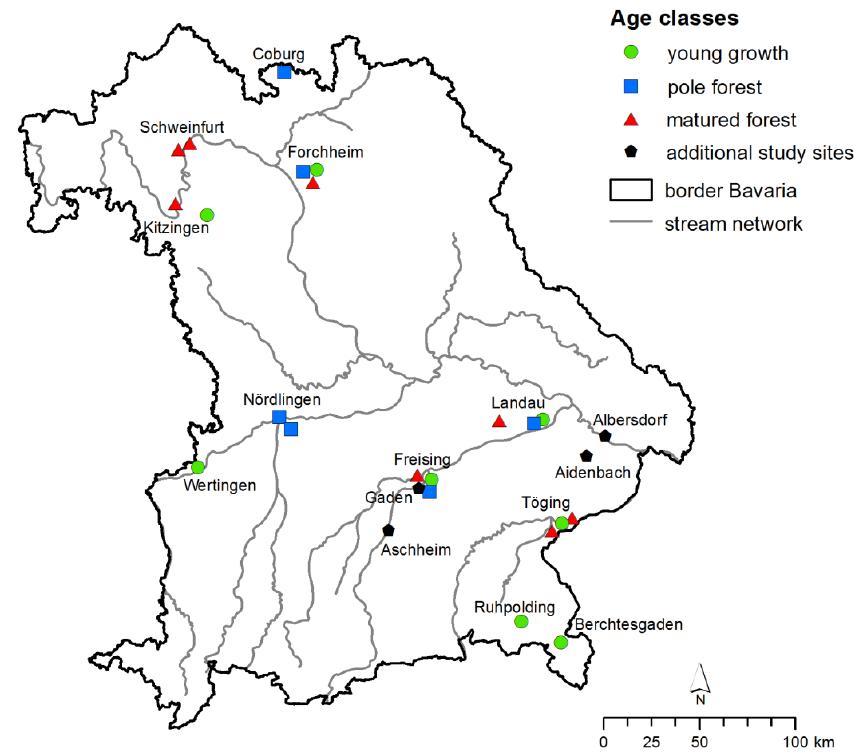
Figure 1. The development of vitality was examined in 22 study sites from 2010 to 2014. Study